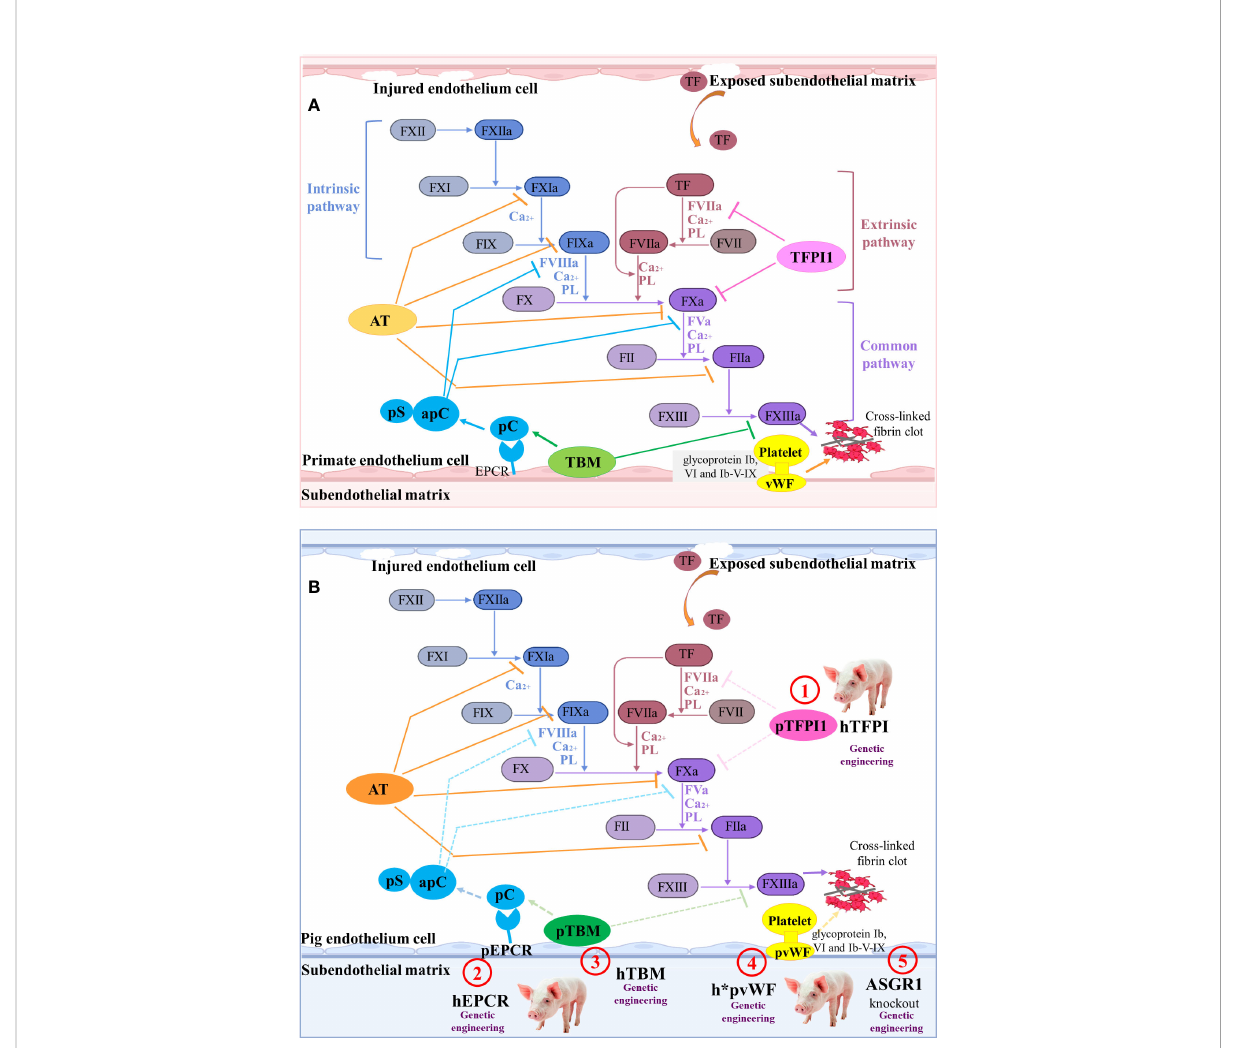
FIGURE 4 The coagulation cascade relating to pig-to-primate xenotransplantation (A) Coagulation cascade in primates. Coagulation factor VII (FVII) in the blood is the promoter of the intrinsic coagulation pathway. Damage to the blood vessel wall exposes the sub-endothelial cells expressing tissue factor (TF) to the blood stream, initiating the extrinsic coagulation pathway regulated by calcium ions. Additionally, in response to shear stress, von Willebrand factor (vWF) interacts with glycoprotein Ib (GPIb), VI, and Ib-V-IX on platelets, which results in platelet activation and adhesion. The clot formation is regulated by several anticoagulant molecules, such as tissue factor pathway inhibitor-1 (TFPI1), antithrombin (AT), Protein C (pC)/protein S (pS), and thrombomodulin (TBM). (B) Mechanisms of coagulation dysfunction after pig-to-primate xenotransplantation. The molecular incompatibilities between primate and pig coagulation – anticoagulation systems exaggerate the coagulation cascade. The pTFPI, pig endothelial protein C-receptor (pEPCR), pTBM, and pvWF are not suf fi cient to inhibit the blood coagulation factor of primates ineffectively shuts down coagulation (dashed lines indicate inadequate inhibition). Thus, the associated gene modi fi cation sites are identi fi ed as ① to ⑤